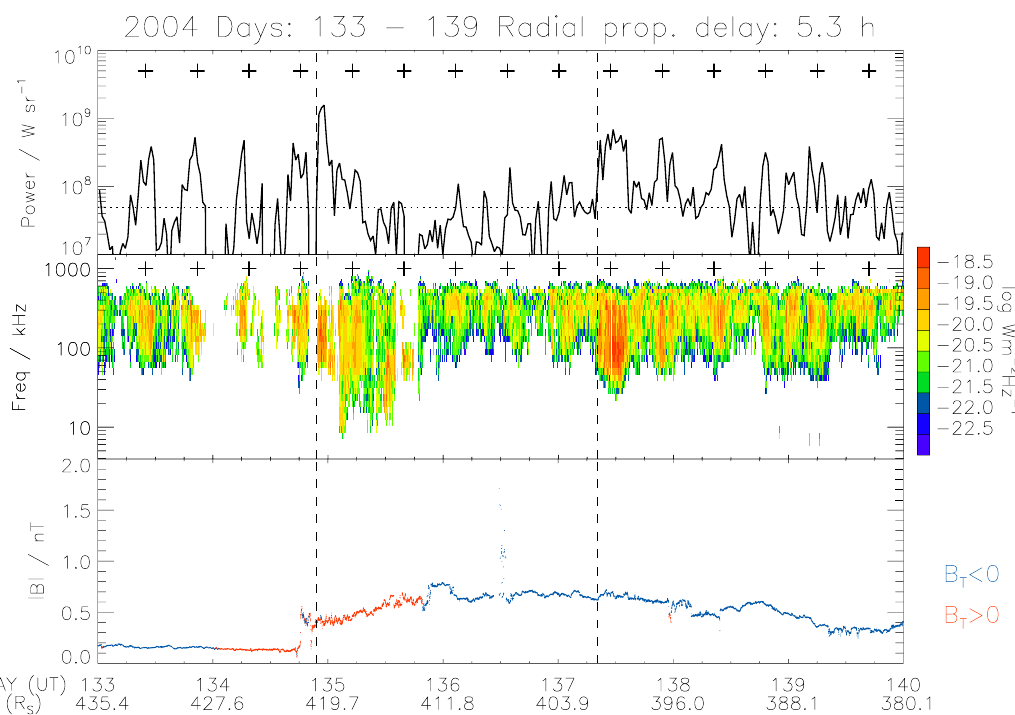
Fig. 2. SKR and IMF data from days 133-139 of 2004, in the same format as Fig.